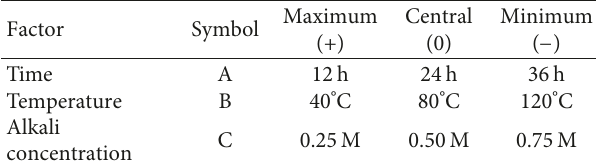
Table 1: Experimental levels of the factors chosen at the experi- mental design.